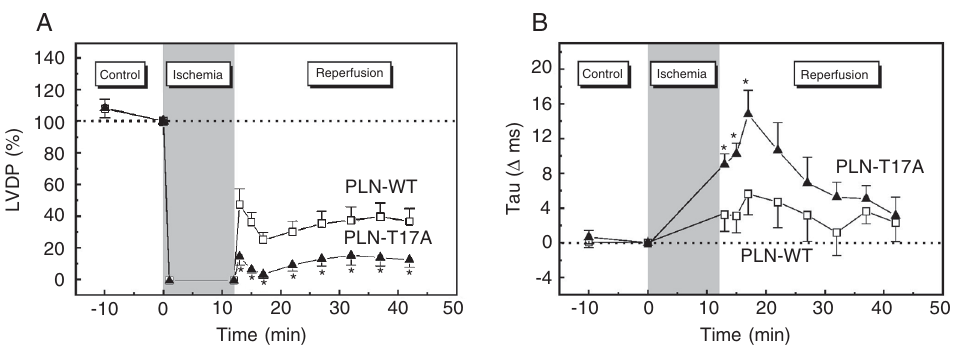
Figure 8. Functional role of Thr 17 phosphorylation in the ischemia- reperfused mouse heart. Time course of left ventricular devel- oped pressure (LVDP; A) and Tau (B) during ischemia and re- perfusion in wild-type phospho- lamban (PLN-WT) and PLN with a Thr 17 to Ala mutation (PLN- T17A) mouse hearts. Mutation of Thr 17 to Ala is associated with diminished contraction and re- laxation recoveries after the is- chemic insult compared to PLN- WT mouse hearts. *P < 0.05 compared to PLN-WT (Student t -test for unpaired observations). Modified from Ref. 36, with per- mission.